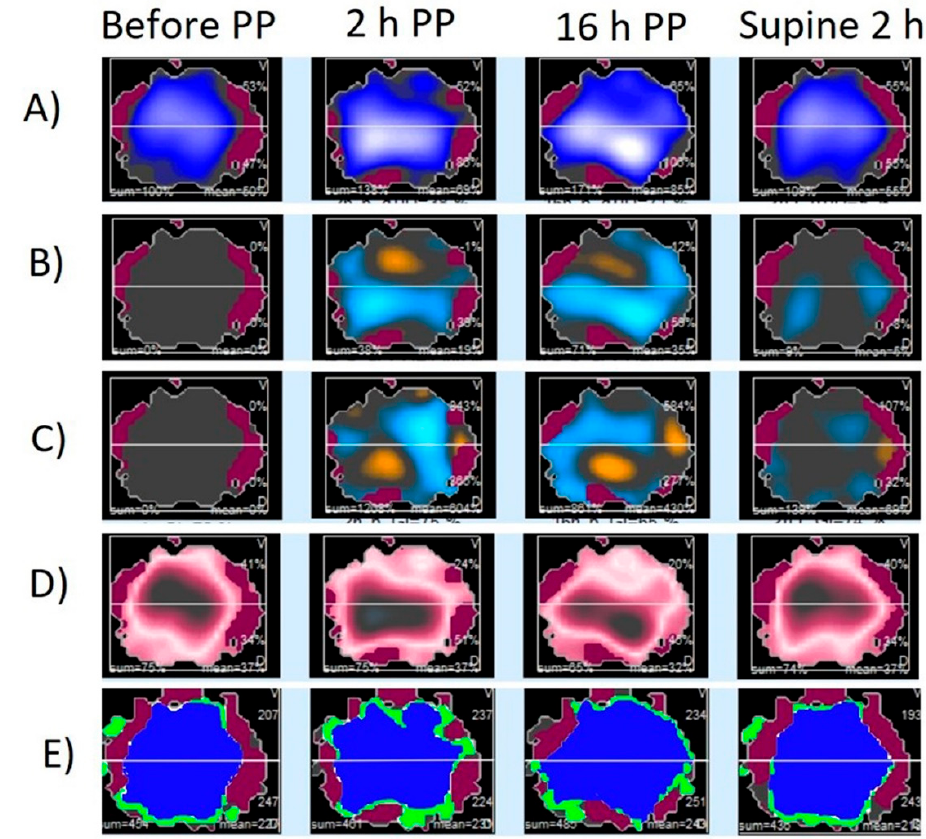
Figure 2. Regional electrical impedance derived parameters during the different study phases in a representative patient. Panel ( A ): Impedance map; Panel ( B ): Impedance changes distribution compared to values before prone position (PP), increases are presented with blue color and decreases with orange; Panel ( C ): End-expiratory impedance changes distribution compared to values before PP, increases are presented with blue color and decreases with orange; Panel ( D ): Global inhomogeneity index map. The bigger the difference between the tidal variation and the median tidal, the darker the color turns. Panel ( E ): Map of well-ventilated pixels (blue color), poorly ventilated pixels (green color), and not ventilated pixels (red color).